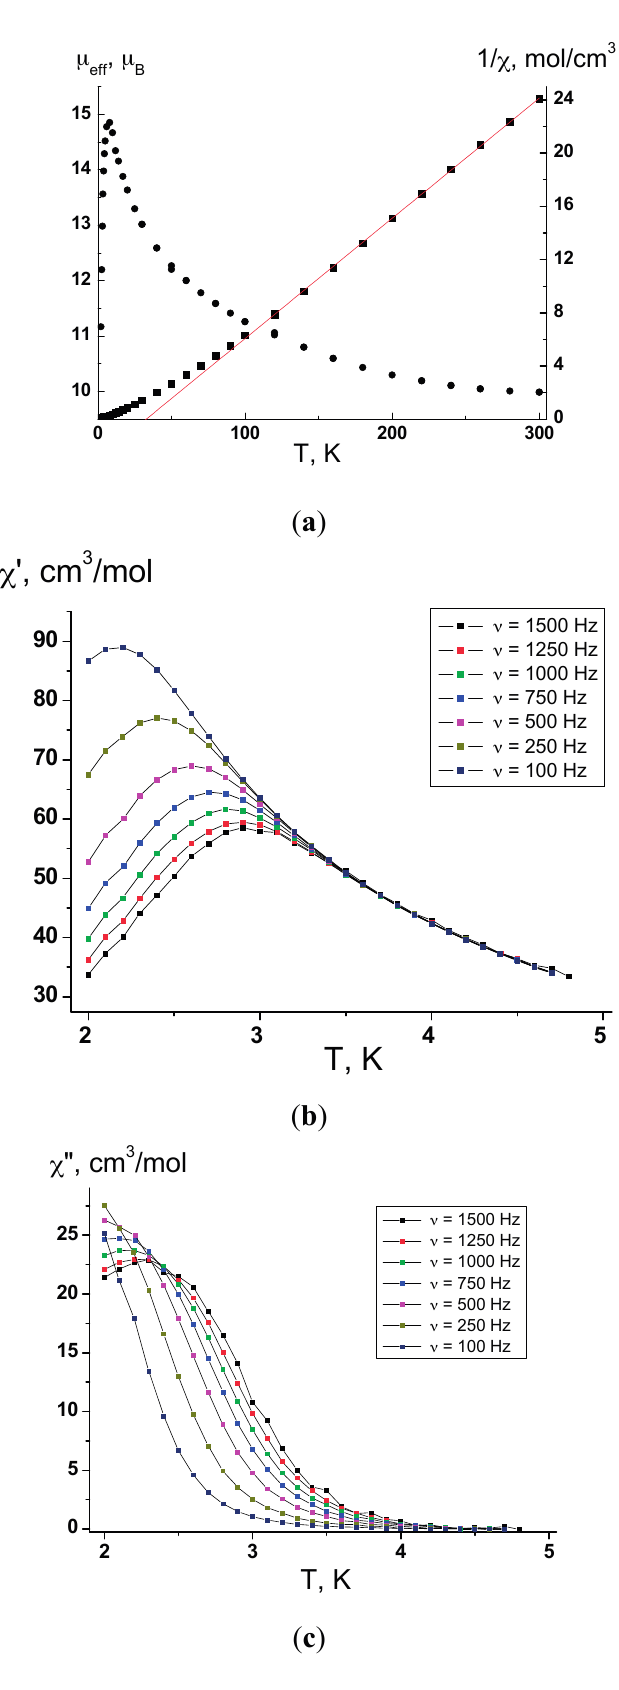
Figure 5. Temperature dependences of µ eff and 1/ χ ( a ) and plot of the in-phase χ ' ( b ) and out-of-phase χ '' ( c ) components of AC susceptibility at different frequencies ( ν ) as a function of temperature for [Co 5 (Piv) 4 L 1 2 L 2 4 ]·0.5Me 2 CO·0.5 С 7 H 16